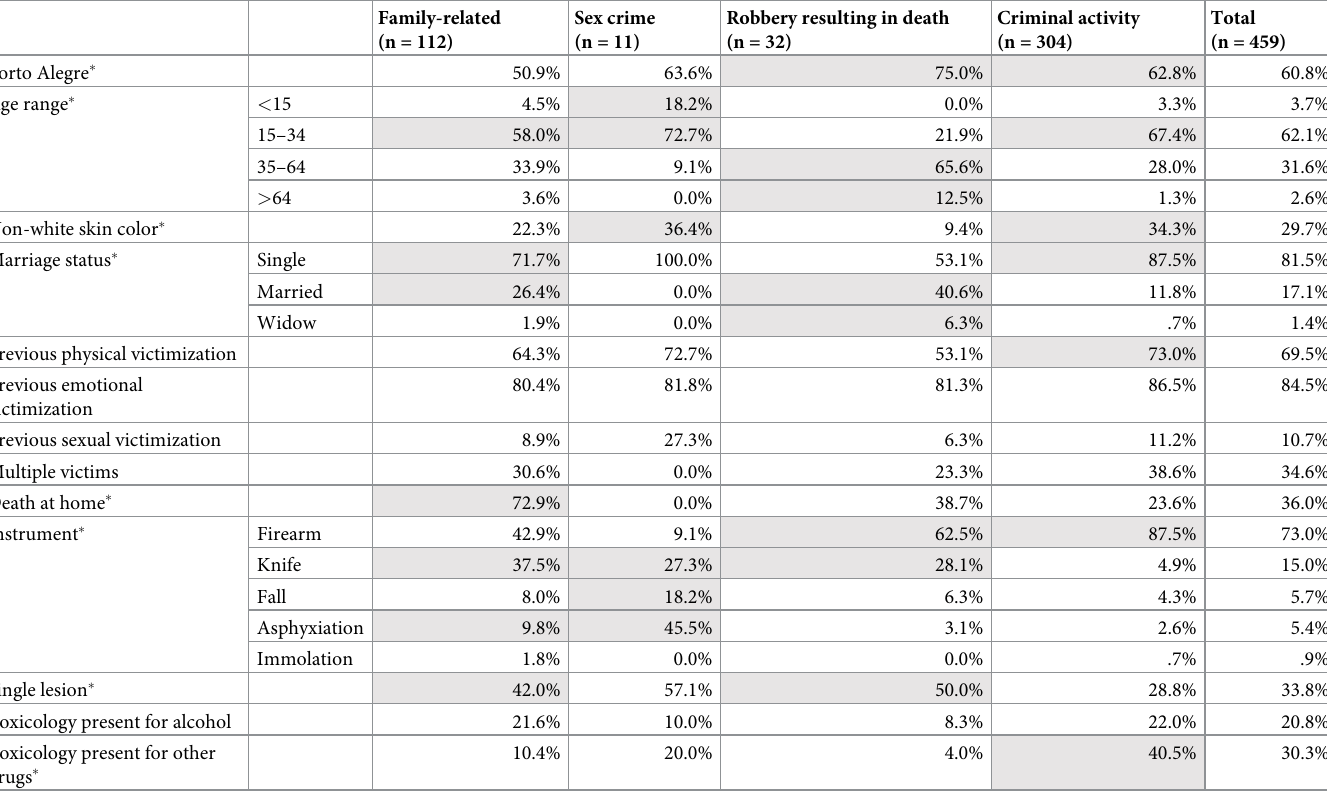
Table 2. Characteristics of homicide victims from the Porto Alegre Medicolegal Department from January 2010 to December 2016 according to motive (n =